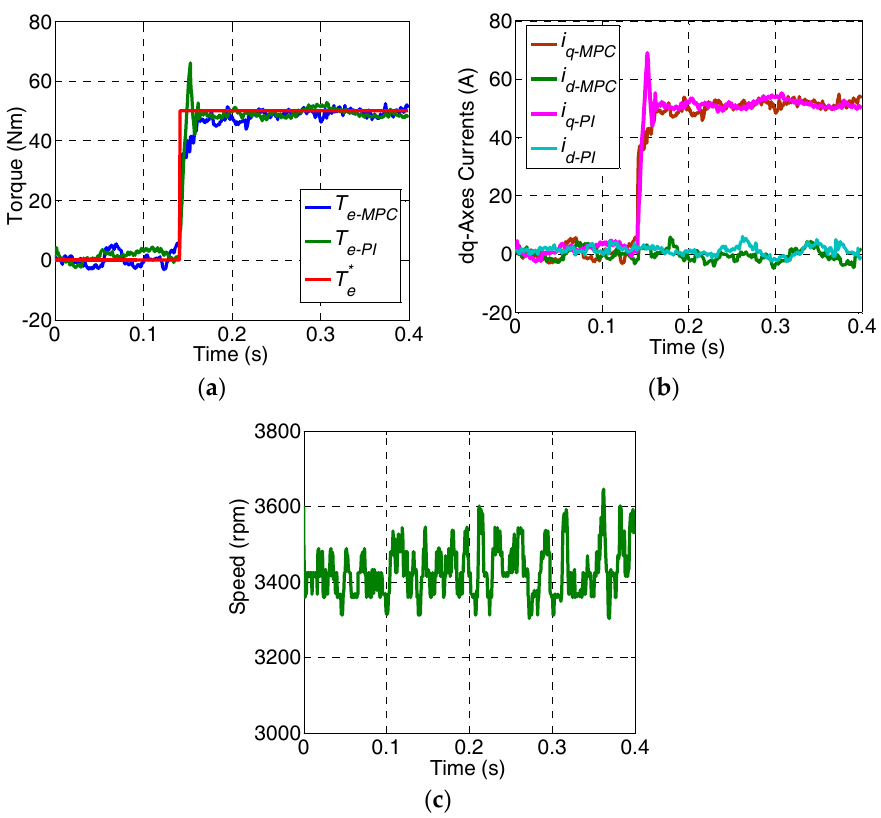
Figure 8. Experiment results under step torque changing of the CTMPC and PI controller. ( a ) Torque; ( b ) dq-Axes Currents; ( c ) Speed.